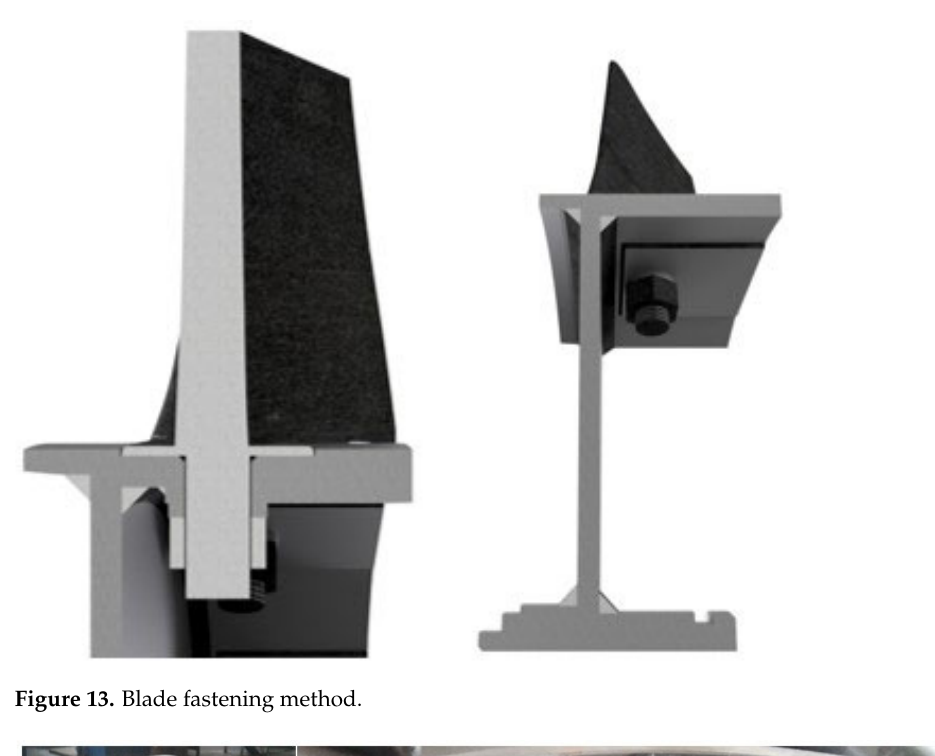
Figure 13. Blade fastening method.